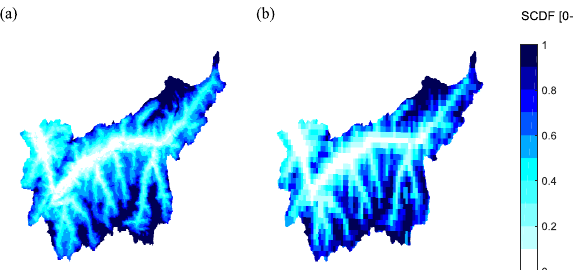
Figure 3. Map of average snow permanence during the period 2000–2008, expressed as the fraction of time in which pixels are snow-covered (snow cover duration fraction, SCDF[0–1]): (a) ob- servations (MODIS) and (b)